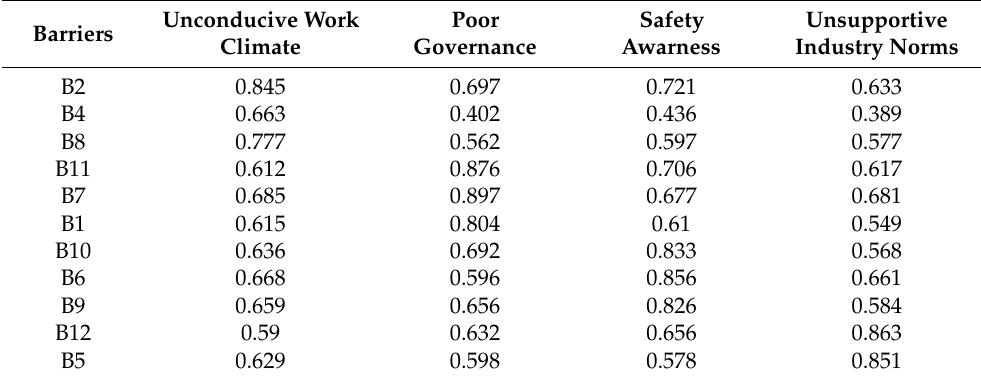
Table 5. Cross loading